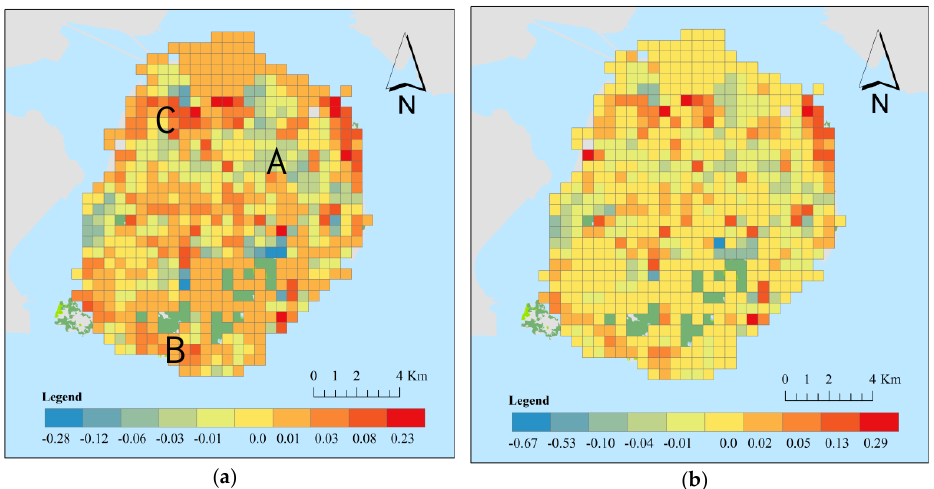
Figure 9. Spatial distribution of the coefficients of ‘attraction density’ (quantified by natural breaks style). ( a ) GWR; and ( b ) GTWR. Region A has negative coefficients of ‘attraction density’; Regions B and C have positive coefficients of ‘attraction density’.